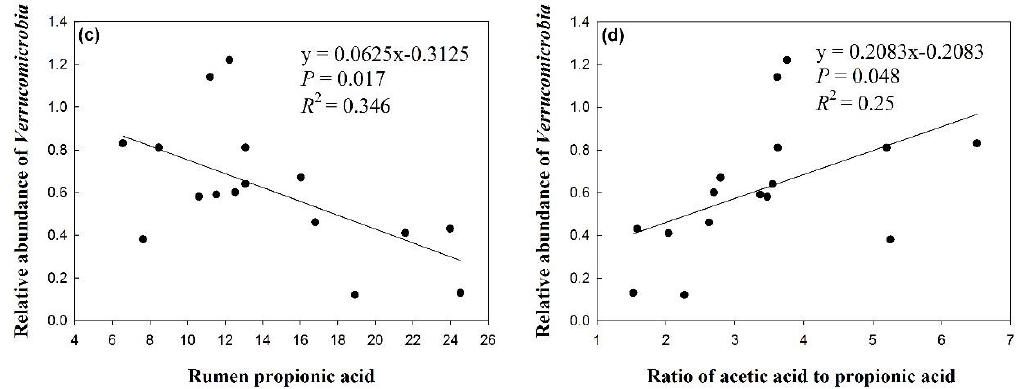
Figure 3. Effects of silage type and chop length on Verrucomicrobia ( a ), and the relationships between the relative abundance of Verrucomicrobia and rumen fermentation ( b , c , and d ). CON, corn silage; R1, 1 cm chopped ramie silage; R2, 2 cm chopped ramie silage; R3, 3 cm chopped ramie silage.